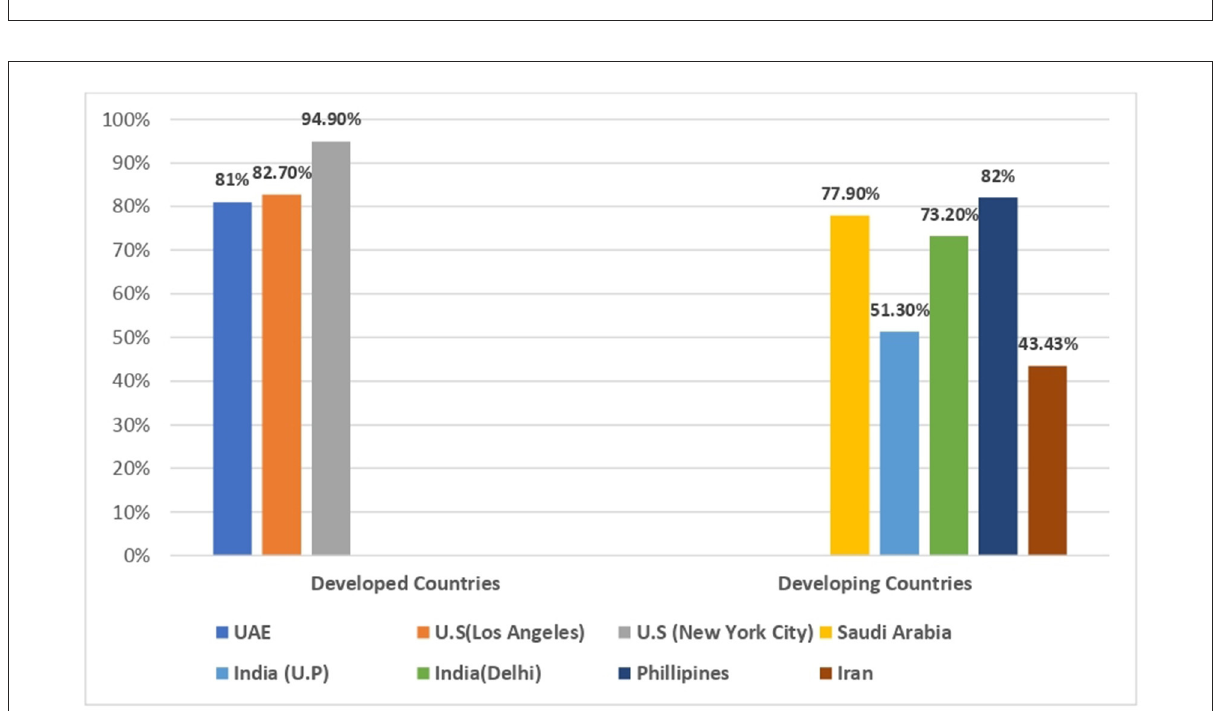
FIGURE5 Overall patient